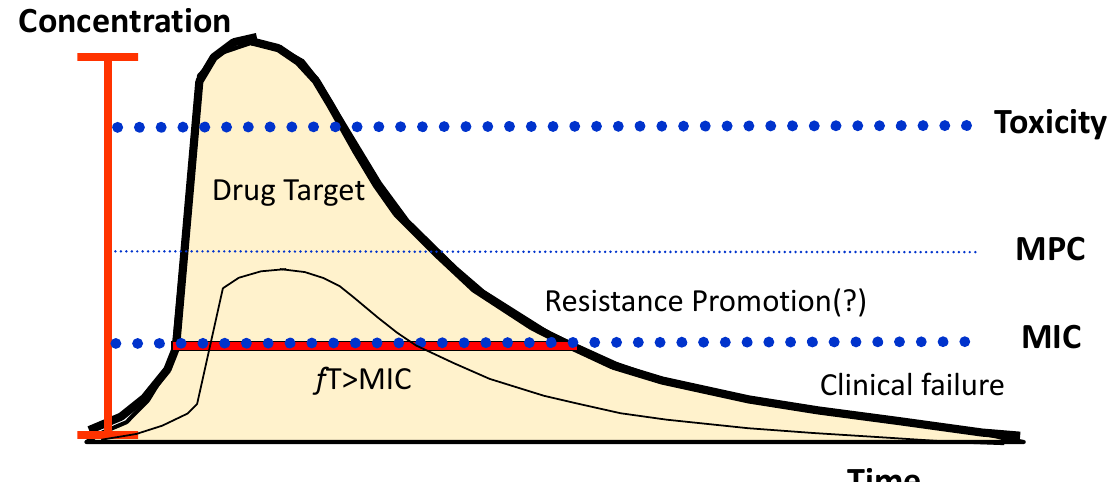
Figure 5. Concentration target of β -lactam antibiotics. Conceptually, the drug-free concentration should be above the MIC and the MPC for the necessary time to lead to bacteria death. A high concentration may lead to toxicity, and a low concentration may be associated with therapeutic failure. A concentration high enough to promote the death of the wild-type bacteria but below the MPC may promote the proliferation of mutants with lower sensibility, although this may depend on other factors (see the text for details). MPC—mutant prevention concentration; MIC—minimal inhibitory concentration; f T—free drug time above MIC. Adapted from [131].